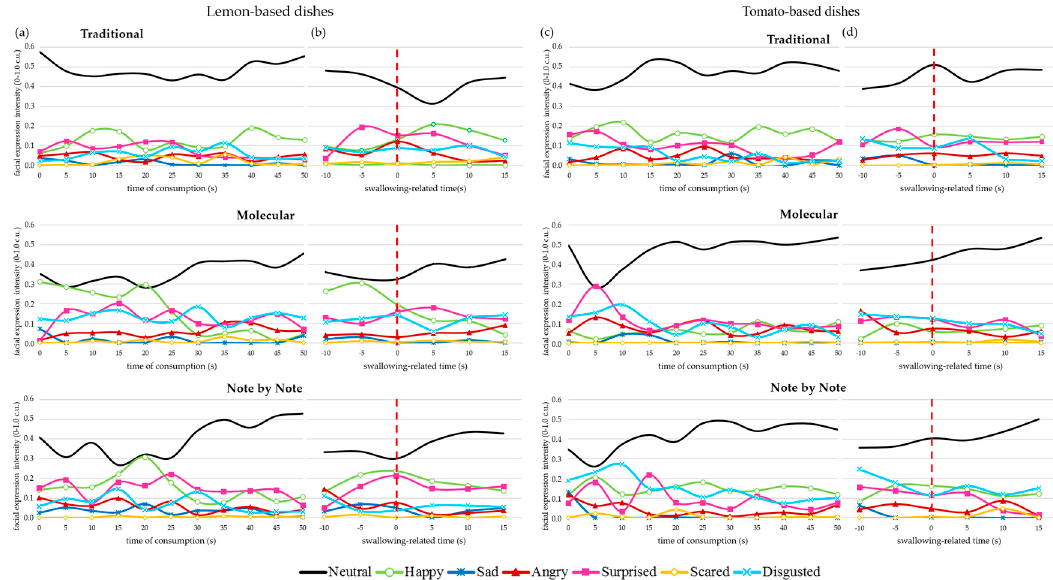
Figure 5. Real-time mimic expresions intensity towards dishes based on ( a , b ) lemon and ( c , d ) tomato: ( a )—during entire consumption time of lemon-based dishes; ( b )—for the swallowing-related time of lemon-based dishes; ( c )—during entire consumption time of tomato-based dishes; ( d )—for the swallowing-related time of tomato-based